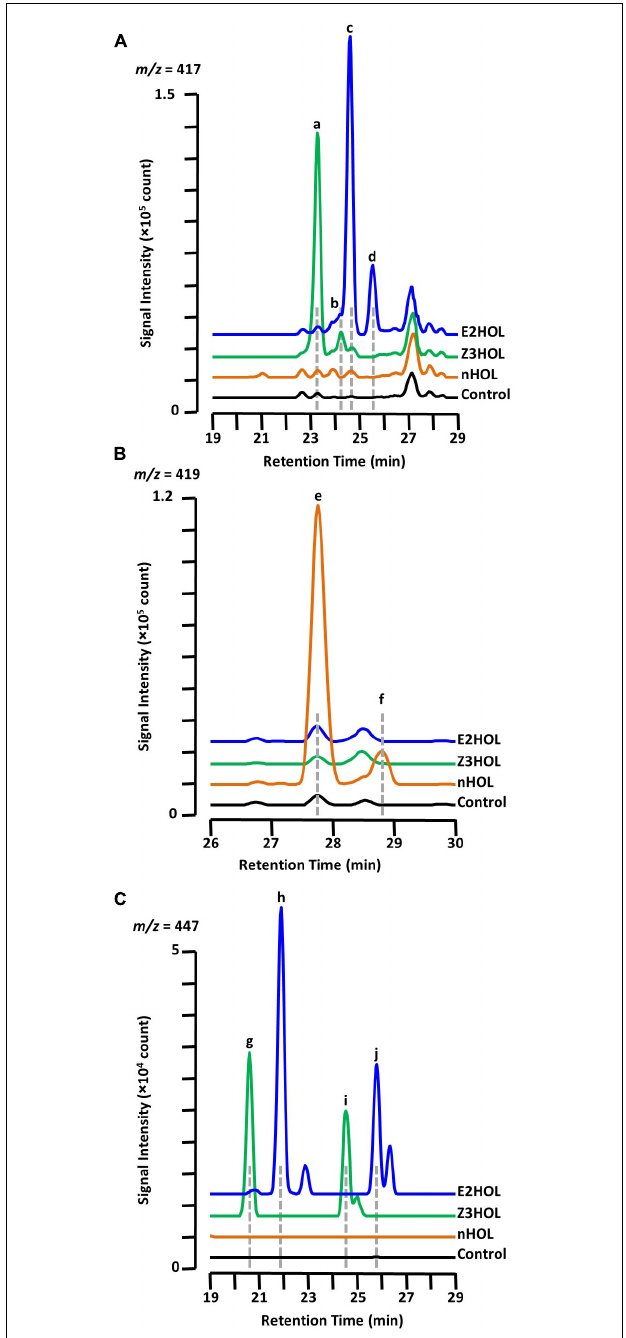
FIGURE 3 | Chromatographic analysis of glycoside accumulation in the green leaf alcohol-exposed tomato. Chromatograms from Z3HOL-, E2HOL-, and nHOL-exposed leaf extracts (green, blue, and orange lines, respectively) were compared at the m/z = 417 (A) , 419 (B) , and 447 (C) , corresponding to the green leaf alcohol-diglycoside conjugates. The chromatogram of the control leaf extract is shown by the black line. Peaks a and b are ( Z )-3-hexenyl vicianoside and ( Z )-3-hexenyl primeveroside, respectively. Peaks c through f are ( E )-2-hexenyl vicianoside, ( E )-2-hexenyl primeveroside, n -hexyl vicianoside, and n -hexyl primeveroside, respectively. Peaks g and i were ( Z )-3-hexenyl dihexosides, and peaks h and j are ( E )-2-hexenyl